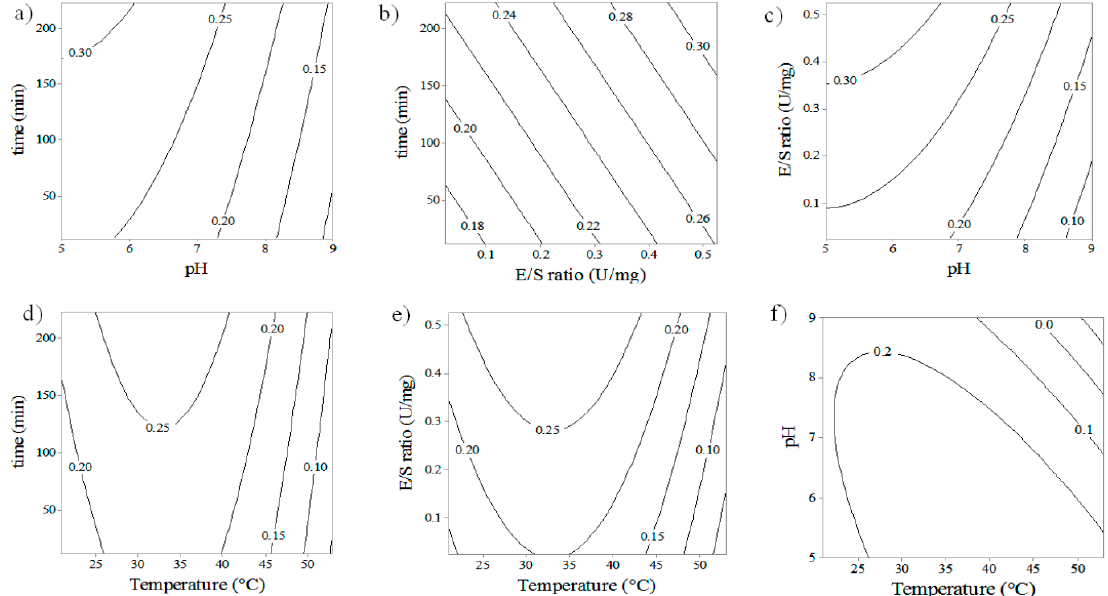
Figure 2. Contour plots depicting the interactive effect of two factors over the liberation of reducing group from hydrolysis of potato galactan by C. japonicus galactanase. ( a ) pH * time; ( b ) E/S * time; ( c ) pH * E/S; ( d ) temperature * time; ( e ) temperature * E/S; ( f ) temperature * pH.